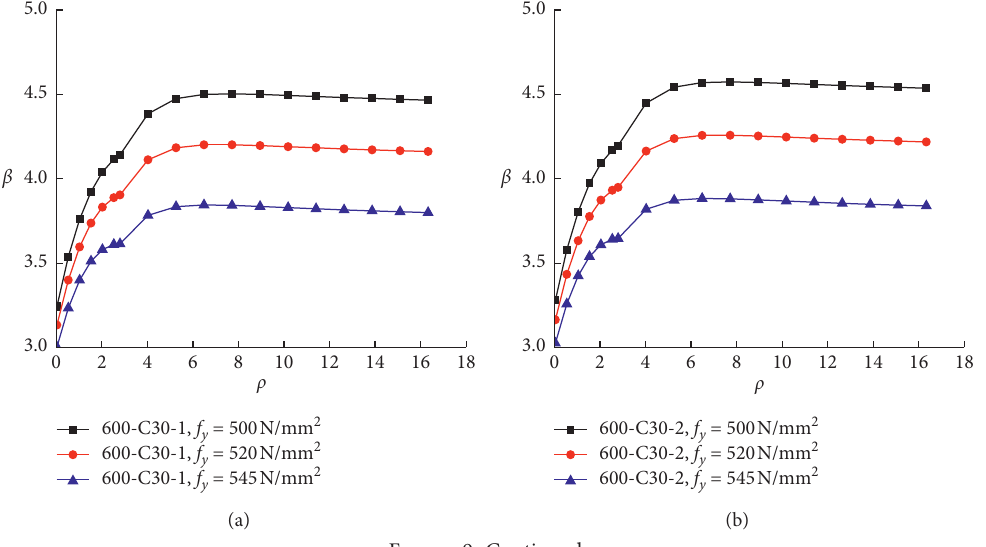
u with M uc calculated by different codes for beams with 600MPa steel